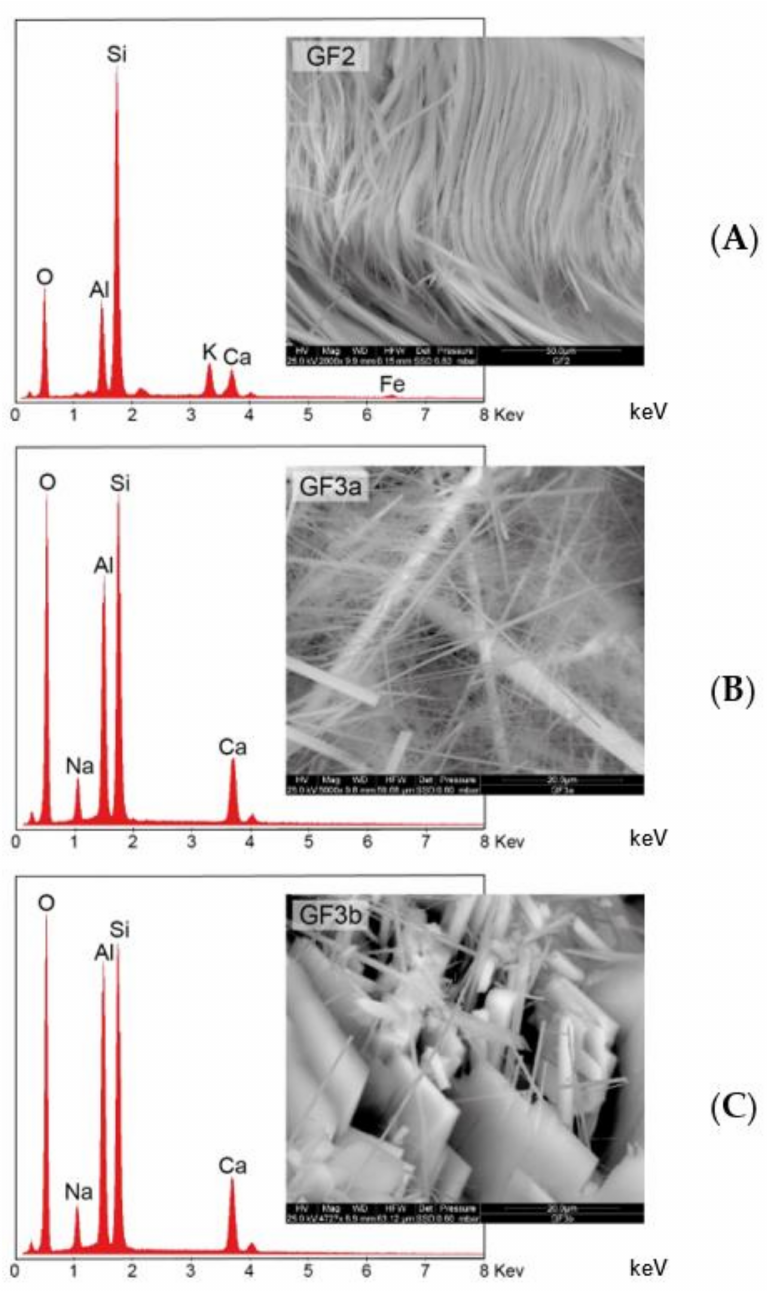
Figure 1. SEM images and representative EDS spectra of the investigated zeolite fibers: ( A ) erionite GF2, ( B ) mesolite GF3a, and ( C ) thomsonite